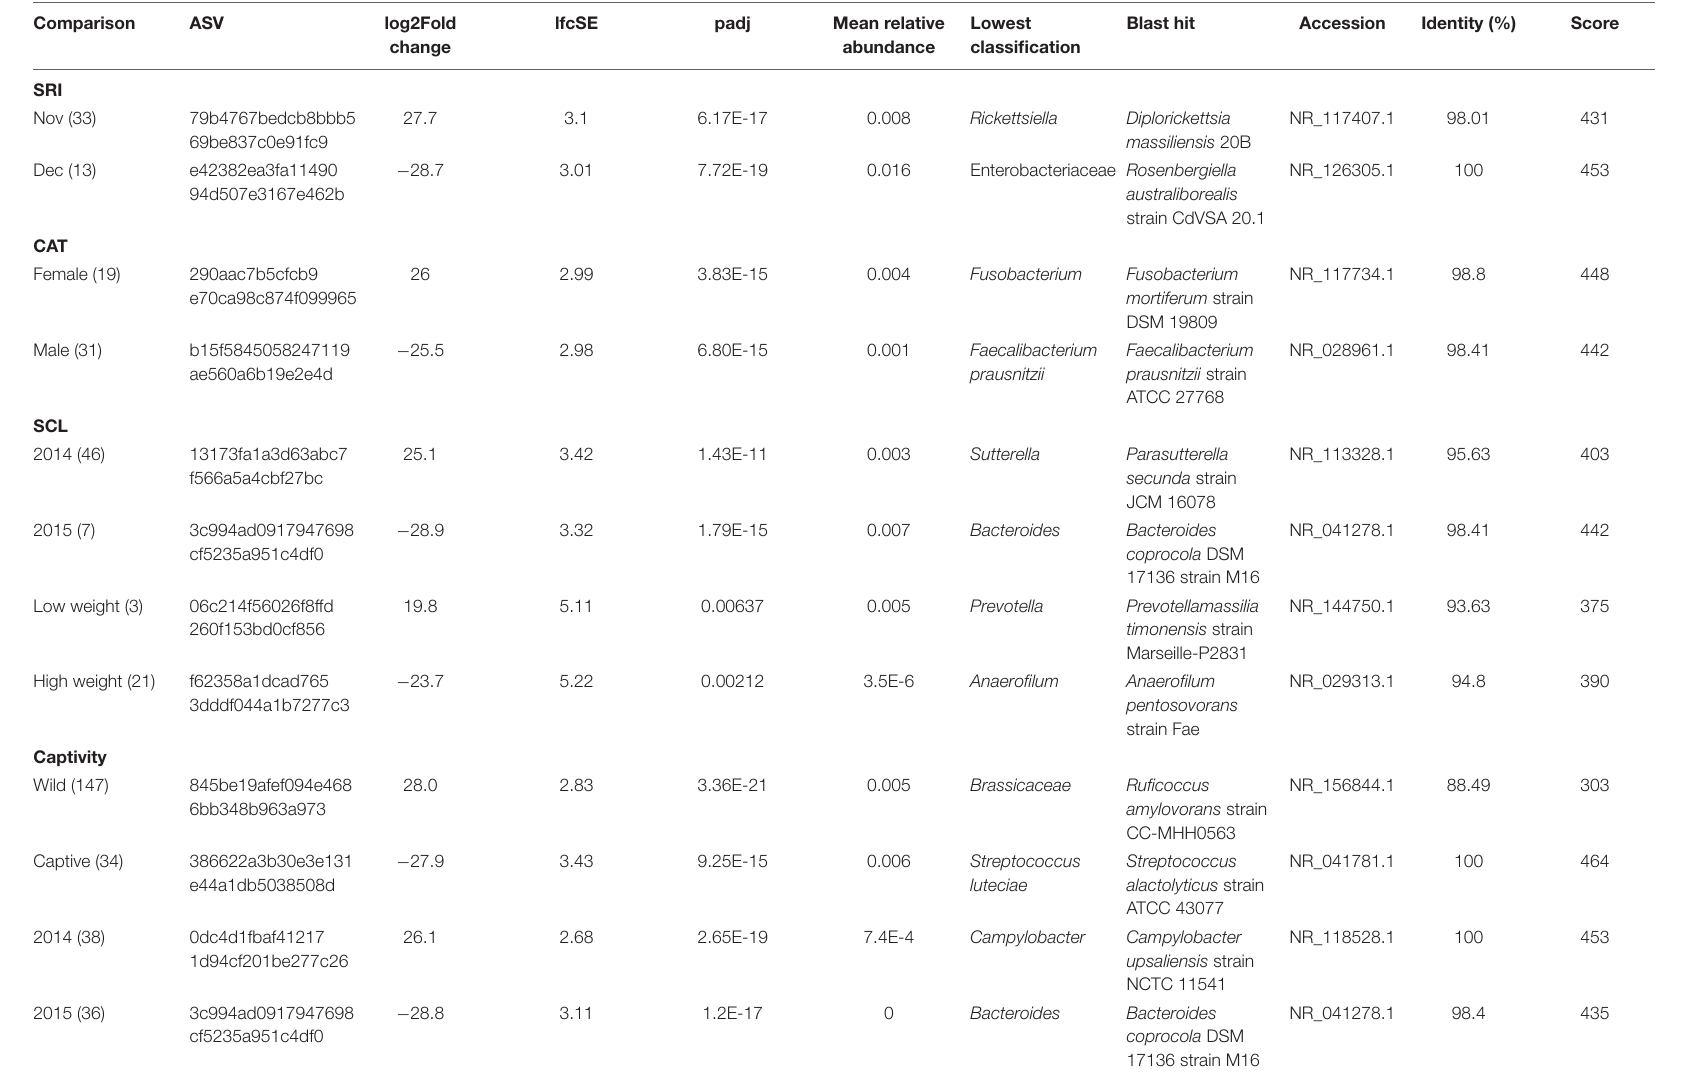
TABLE 2 | Top differentially abundant ASVs for significant comparisons.